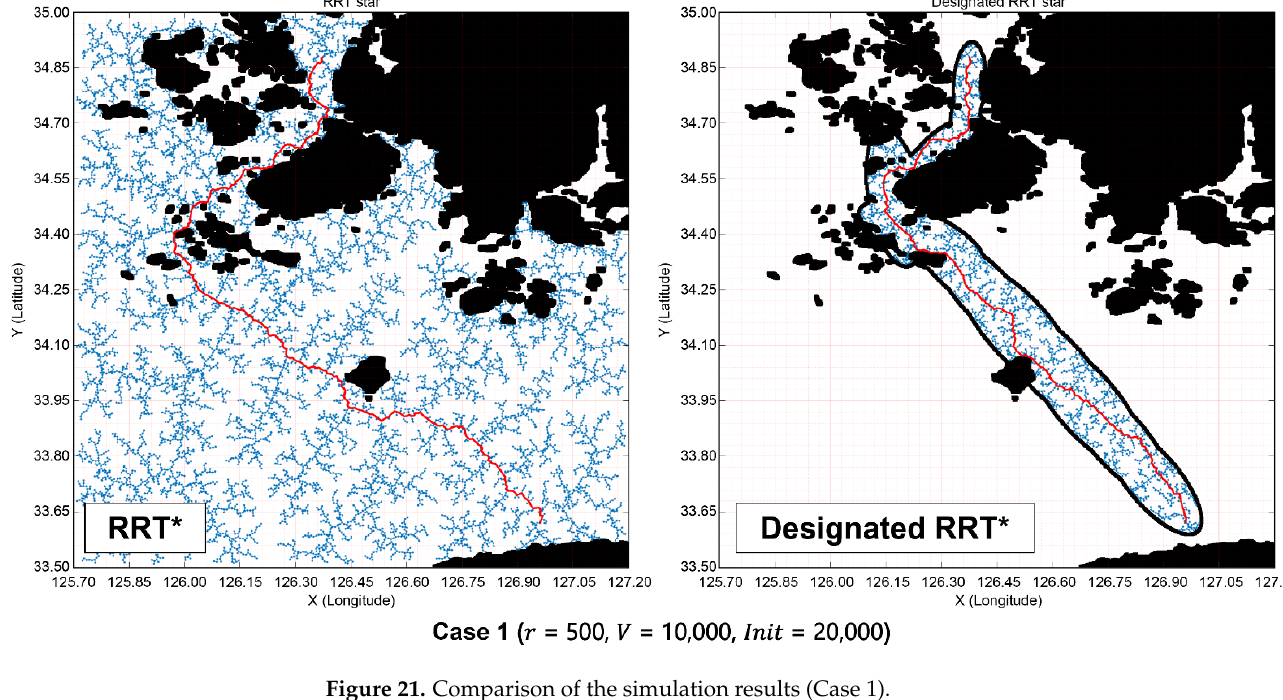
Figure 21. Comparison of the simulation results (Case 1)